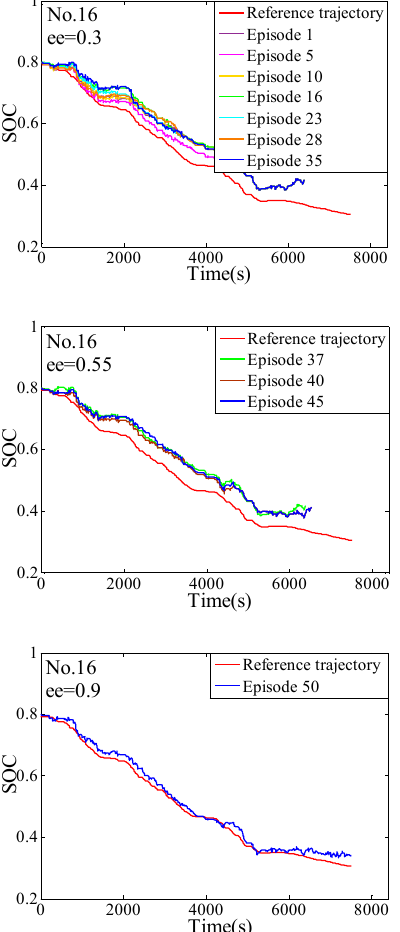
Figure 15. The training process of combined driving cycle 16.